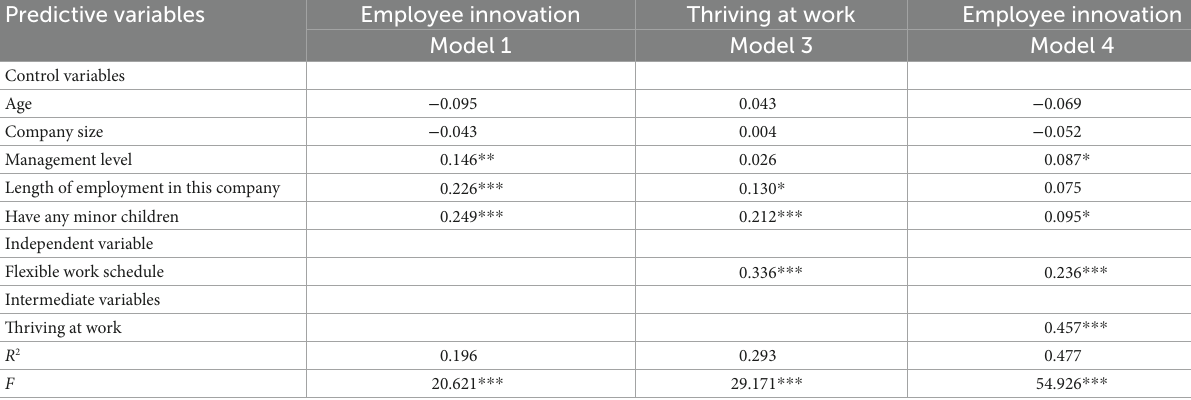
TABLE 5 Result of mediating effects tests.